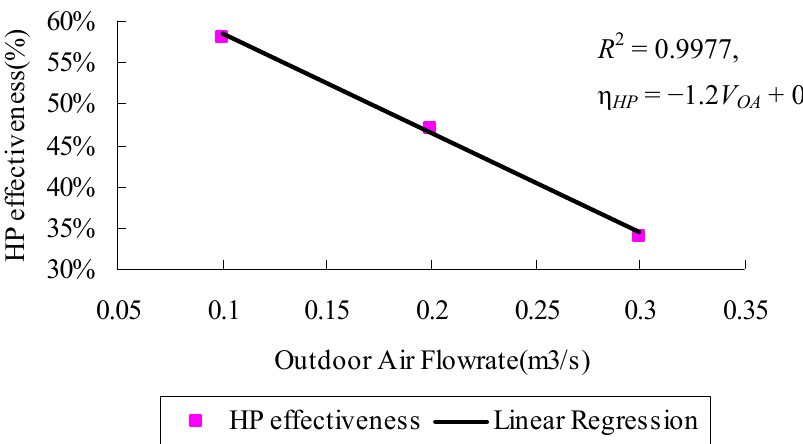
Figure 13. HP effectiveness of various Airflow